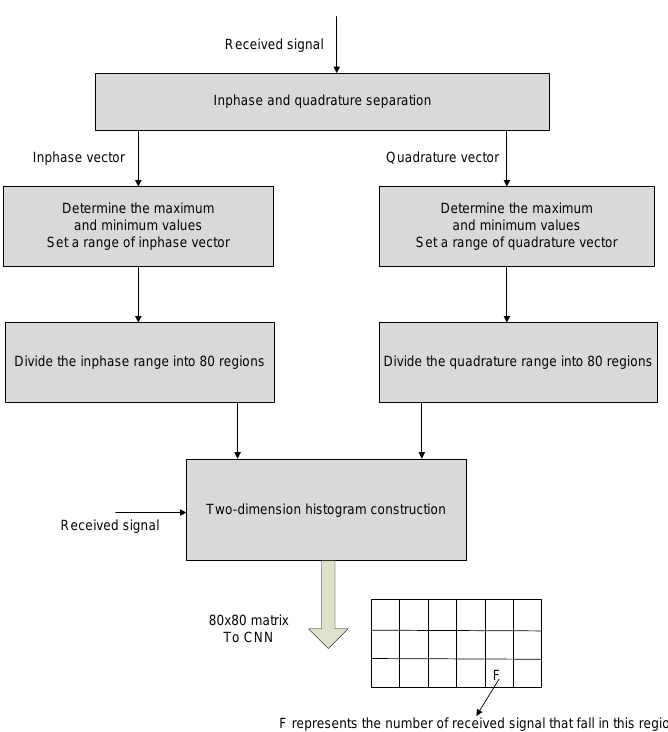
Figure 3. Data generation and feature extraction